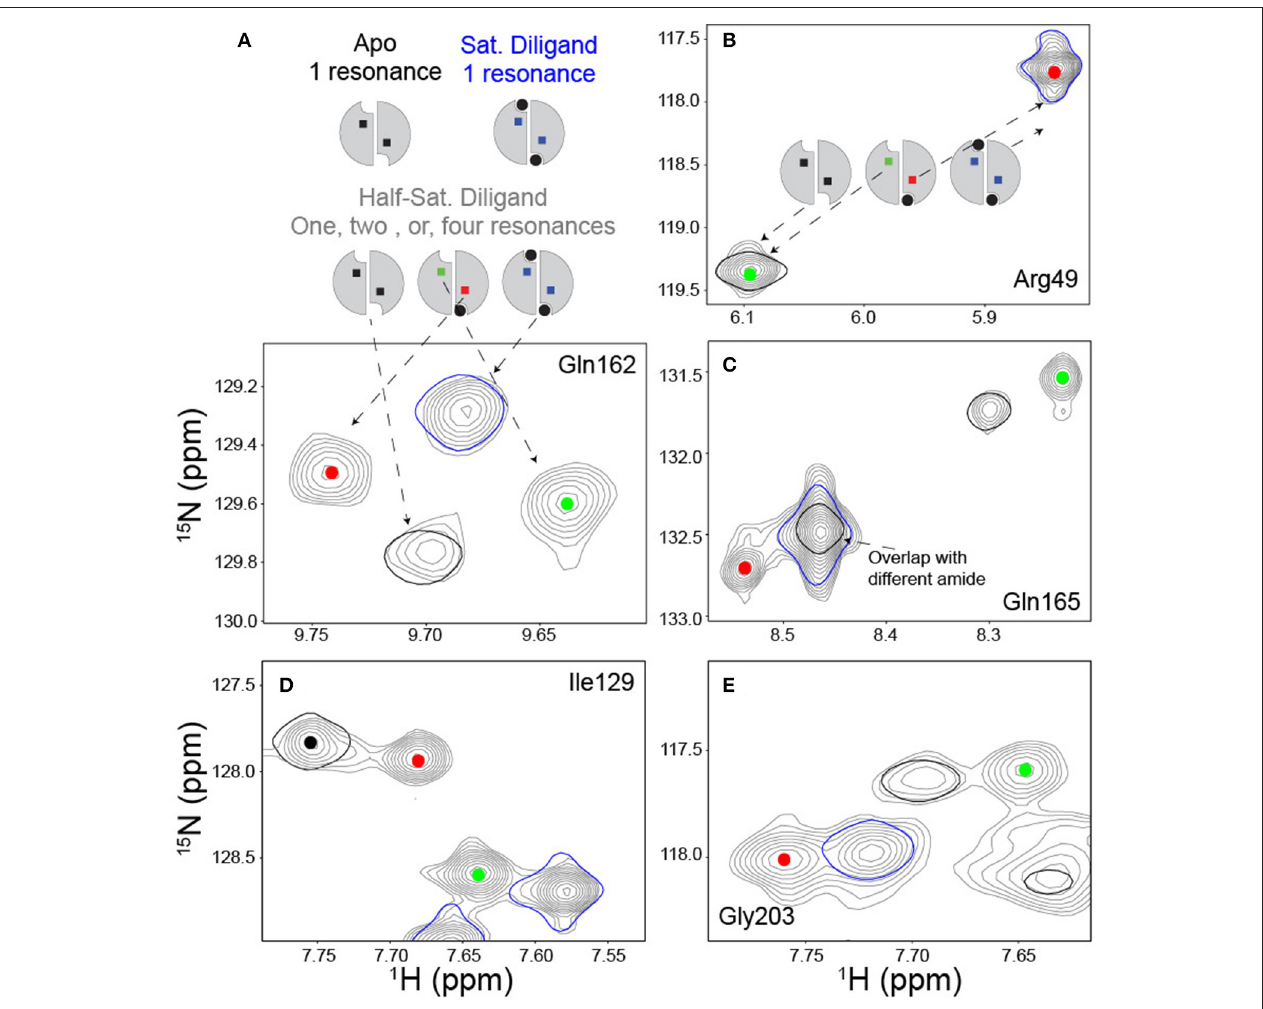
FIGURE 5 | Ligand state peak multiplets in a FdUMP/mTHF (diligand) titration. (A) Scheme and spectra of amide with a quartet peak pattern at midpoint of diligand titration. In the scheme, the ligand is shown in black circles and the reporter amide is shown in squares. The titration midpoint spectrum is shown in gray, and the apo and saturated diligand spectra (single contour lines) are shown in black and blue respectively. The red and green dots serve to identify resonances arising from the empty and bound subunits respectively of the singly bound state. (B) Example of amide reporter with a doublet peak pattern in which the signal from the empty subunit of the singly bound state overlays with the apo spectrum and the signal from the bound subunit of the singly bound state overlays with the saturated dilagand spectrum. Spectra are colored as described in (A) . (C–E) Panels provide additional examples of quartet amides and are colored as described